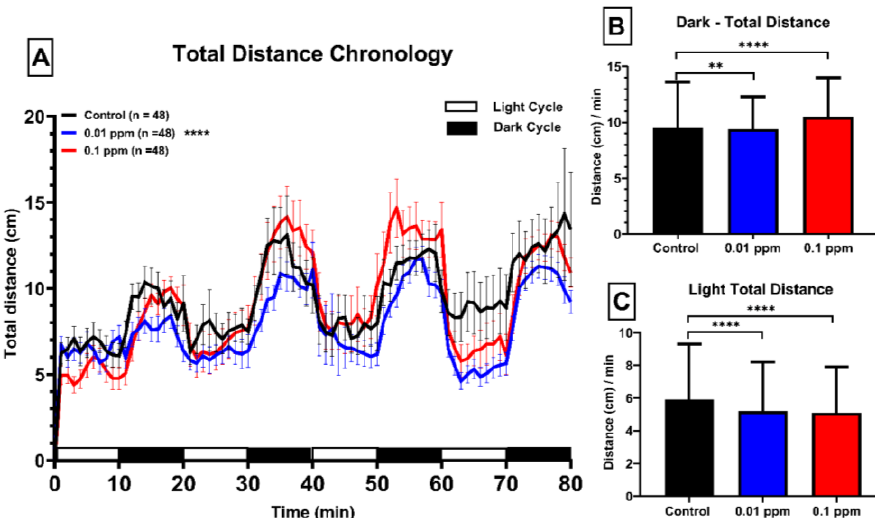
Figure 2. Total distance chronology of zebrafish larvae after exposure of Paclobutrazol. ( A ) The total distance traveled in either light or dark phases of zebrafish larvae after treated with 0 (black color), 10 µg/L (0.01 ppm) (blue color), or 100 µg/L (0.1 ppm) (red color) ppm of Paclobutrazol. Quantitative comparison of total distance traveled in the light phase ( B ) or dark phase ( C ) for zebrafish larvae after exposure of Paclobutrazol. The data are expressed as the means ± S.E.M. and analyzed by the one-way ANOVA with the Geisser–Greenhouse correction (** p < 0.01, **** p <